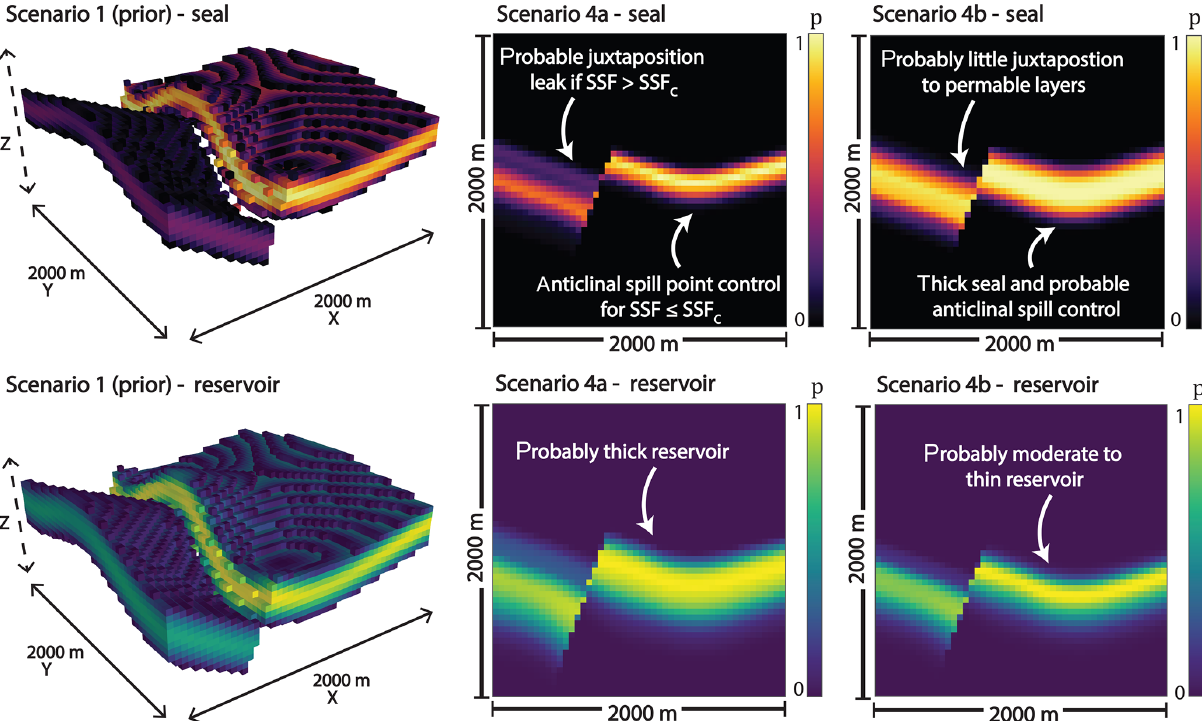
Figure 6. Probability field visualizations for seal and reservoir units in Scenarios 1 (prior), 4a, and 4b. For Scenario 1, we used 3-D voxel visualizations and set a threshold at a probability of 0.5 (only voxels with a probability higher than 0.5 are shown). It can be recognized that the seal is disrupted across the fault in more than 50% of the prior model realizations. For the other scenarios, we show the full probability field for both units on a section through the middle of the model ( y = 500m), parallel to the x – z